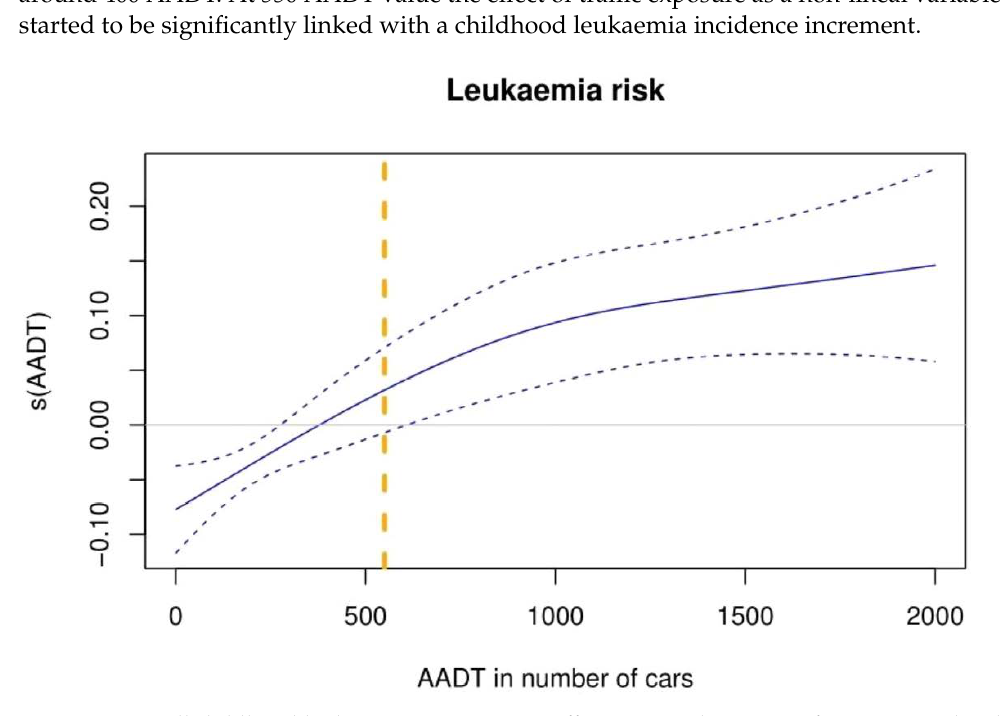
Figure 2. Overall childhood leukaemia exposure to traffic, measured in terms of AADT. Graphical representation of adjusted non-linear regression model for sex, year of birth, SES, and AR. s(AADT) represents AADT smooth effect on childhood leukaemia incidence. Blue dashed lines represent lower and upper 95% CI. Orange dashed line represents 550 AADT on the x -axis.